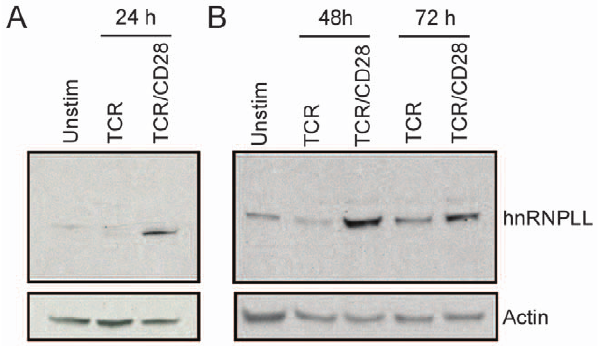
Figure 7. CD28 costimulation promotes and sustains hnRNPLL protein expression in CD4 T cells. Sorted naı¨ve CD4 + CD25- T cells from wild type mice were stimulated with bead-bound anti-CD3 alone or anti-CD3 plus anti-CD28 for the indicated times. (A, B) These results are representative of at least 4 independent experiments.